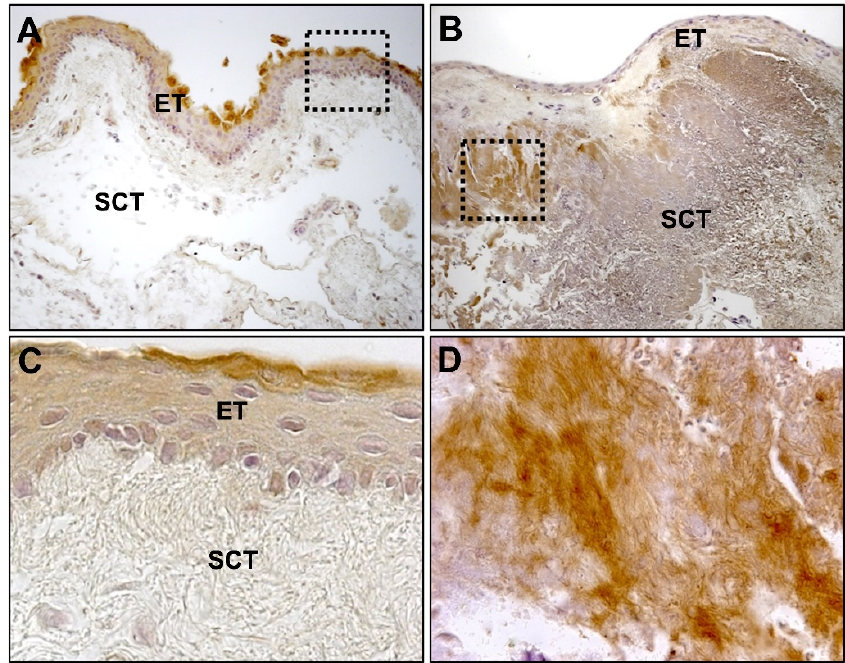
Figure 6. Images of immunohistochemical tropoelastin staining show an increased expression in pathologic tissue: ( A ) Conjunctival tissue (×100); ( B ) pterygium (×100); ( C , D ) detailed view of the squared section in ( A , B ), respectively (×630). (ET, epithelial tissue; SCT, subepithelial connective tissue).